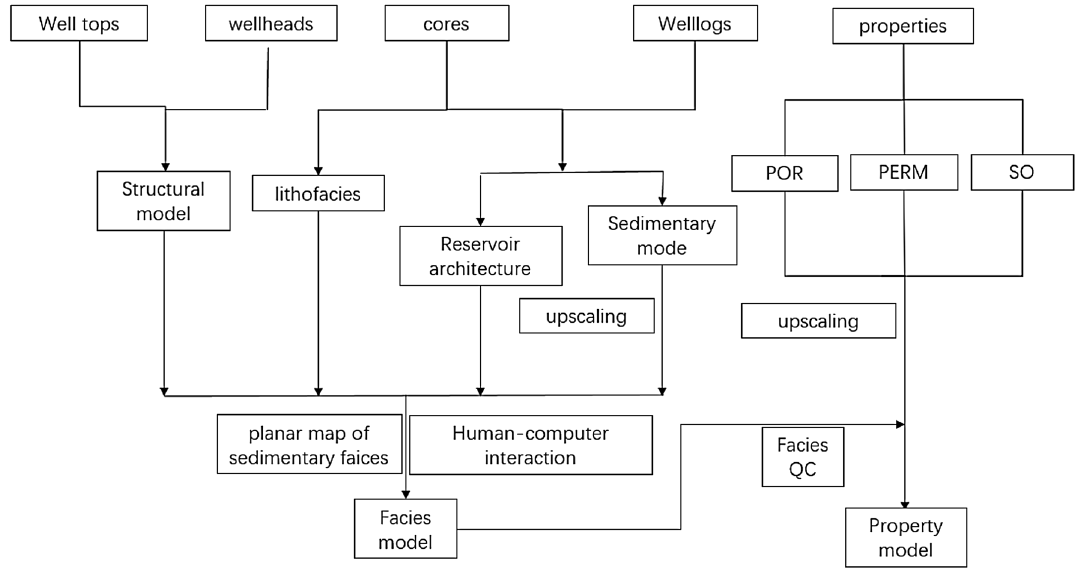
Fig. 4 The workflow of single sand body